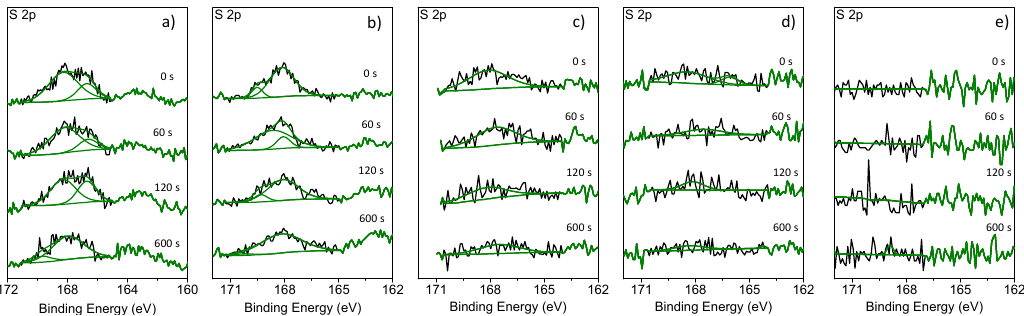
Figure 5. XPS S 2p core spectra of graphite electrodes, after five charge/discharge cycles at 0.1C in graphite/Li cells with different amounts of FEC in the electrolyte ( a ) 1 M LiPF 6 in EMS; ( b ) 1 M LiPF 6 in EMS:EA (1:1); ( c ) 1 M LiPF 6 in EMS:EA (1:1) with 1% FEC and ( d ) 1 M LiPF 6 in EMS:EA (1:1) with